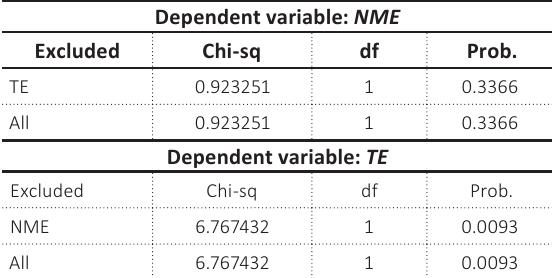
Table 5. VAR Granger causality/block exogeneity Wald tests